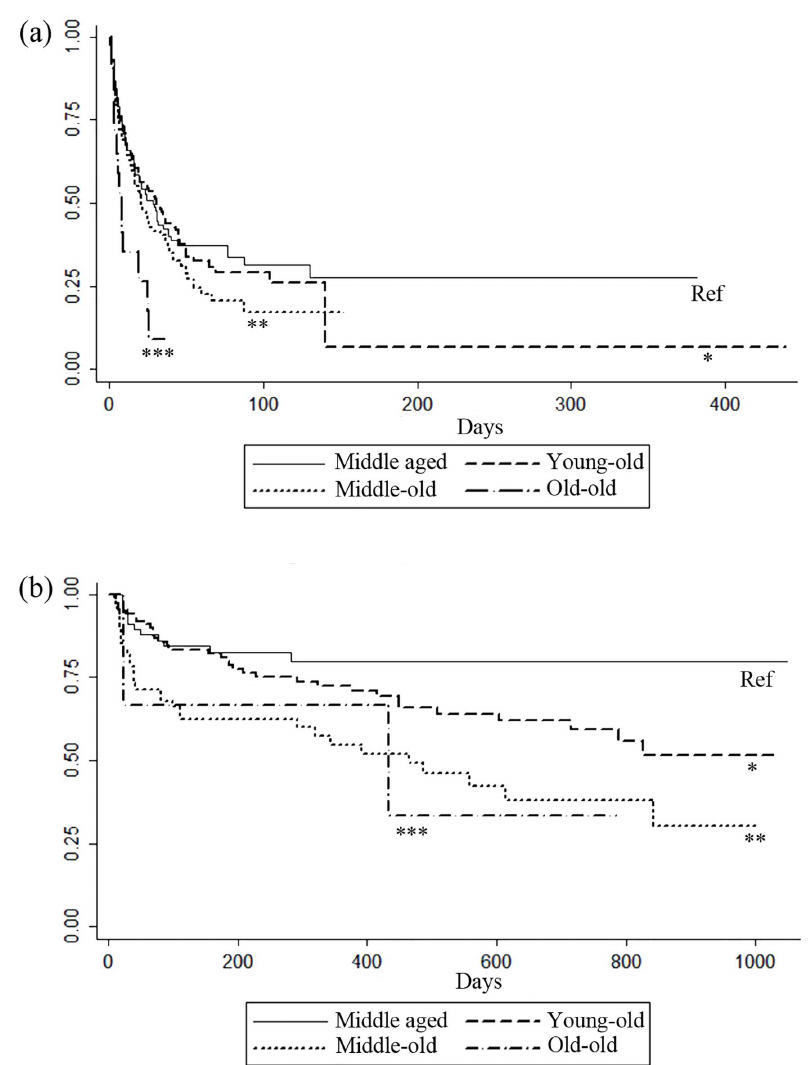
Fig 1. Short- (a) and long-term (b) Kaplan-Meier survival plot of patients with acute kidney injury who underwent continuous renal replacement therapy by different elderly groups. Survival difference was not observedin the young-old agedcohort when comparedto the middle aged cohort in both short and long term follow up periods. (a) When comparedto the middle aged cohort, survival difference was observedonly in the old-oldaged cohort. * Log rank betweenmiddle agedand young-oldcohort, p = 0.699, ** Log rank between middleaged and middle-oldcohort, p = 0.126, *** Log rank betweenmiddleaged and old-oldcohort, p = 0.005 (b) When comparedto the middleaged cohort, survival difference was observedin the middle–old and old-oldcohort. * Log rank betweenmiddle agedand young-oldcohort, p = 0.074, ** Log rank between middleaged and middle-oldcohort, p = < 0.001, *** Log rank betweenmiddle aged and old-oldcohort, p = 0.049.